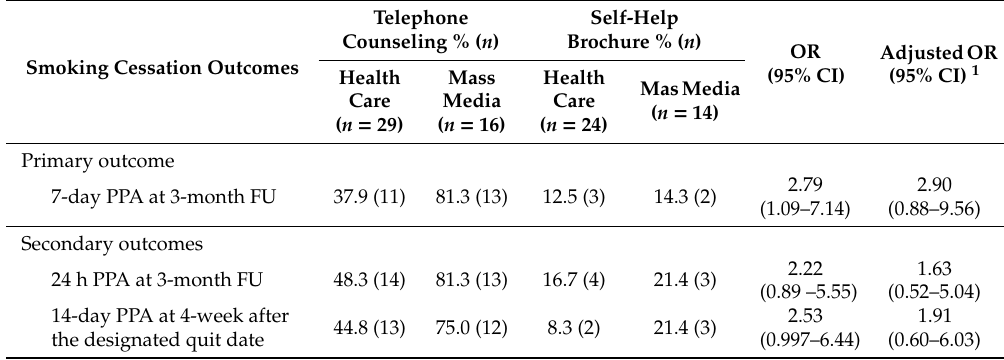
Table 3. Smoking cessation outcomes between condition and recruitment